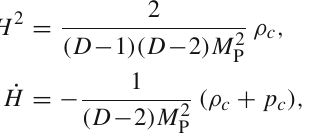
loop level. At the background level this approximation cor- responds to what is known in the literature as semiclassical gravity ,buttheone-loopapproximationsgoesbeyonditsince it includes higher order moments as well, so that background becomes stochastic